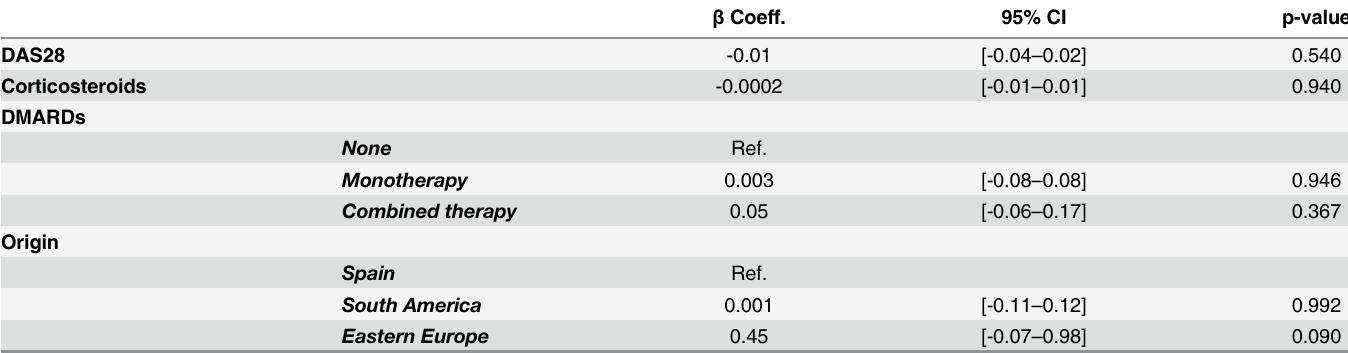
Table 3. Multivariate analysis of variables associated with VPAC2 expression during follow-up of patients with early arthritis.